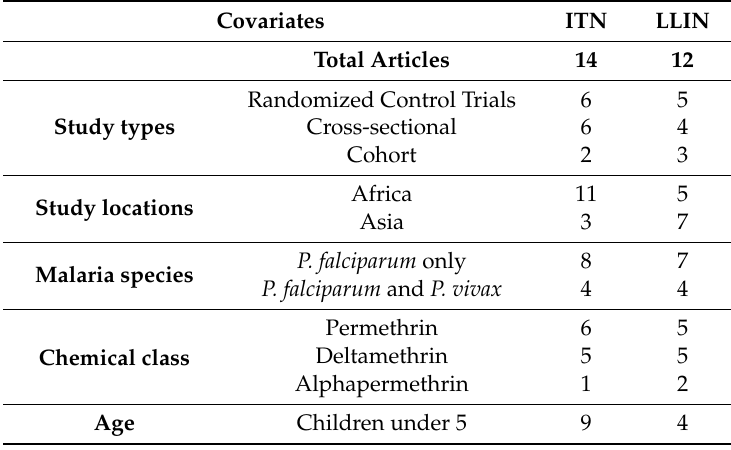
Table 1. Study descriptions (counts of article